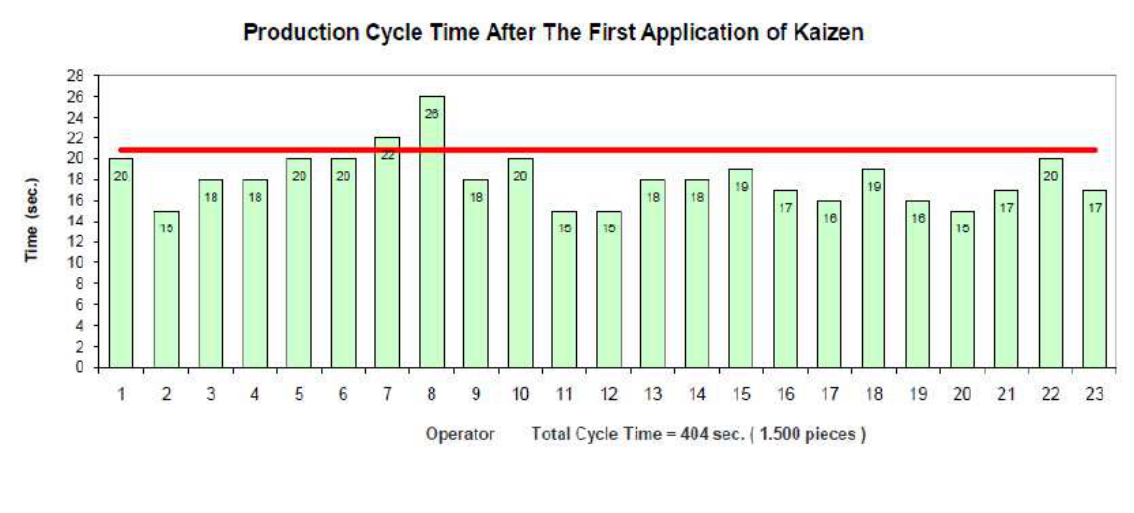
Figure 2. Production Cycle Time After the First Application of